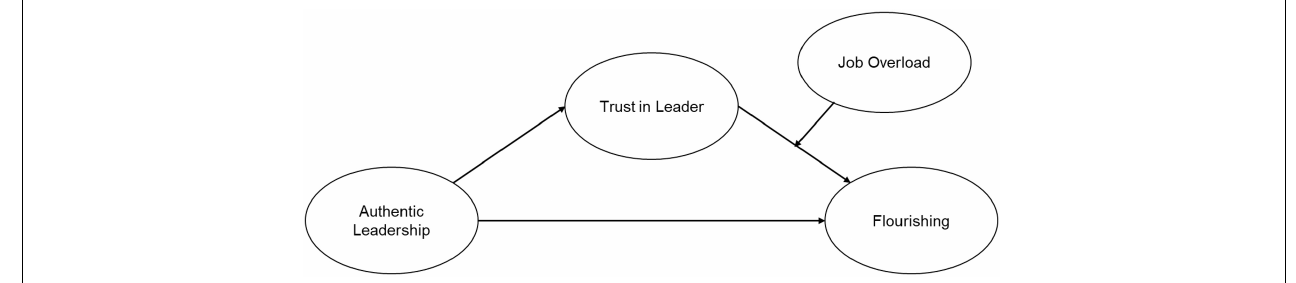
FIGURE 1 | The conceptual